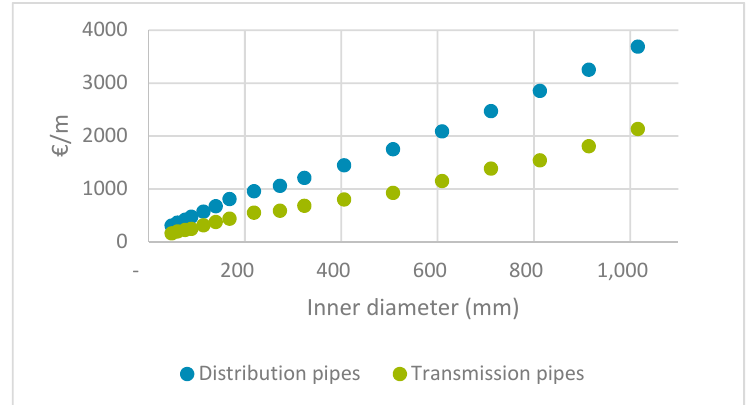
Figure 4. Investment costs of distribution and transmission pipes. Data from [38].